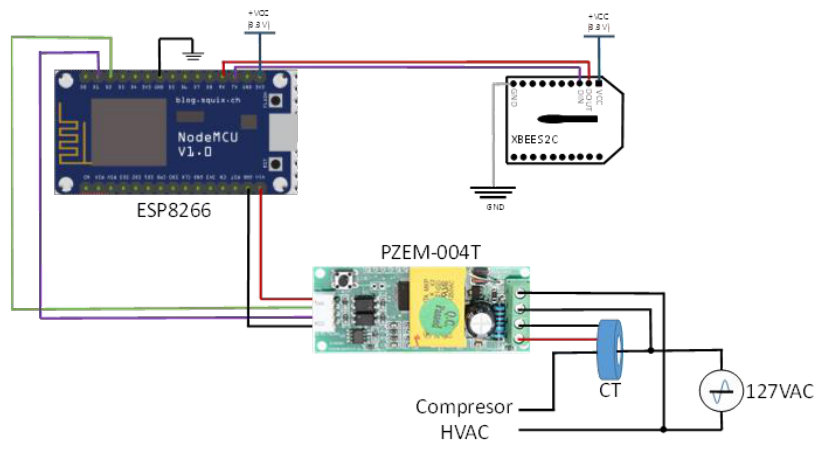
Figure 3. Electrical parameter meter circuit.